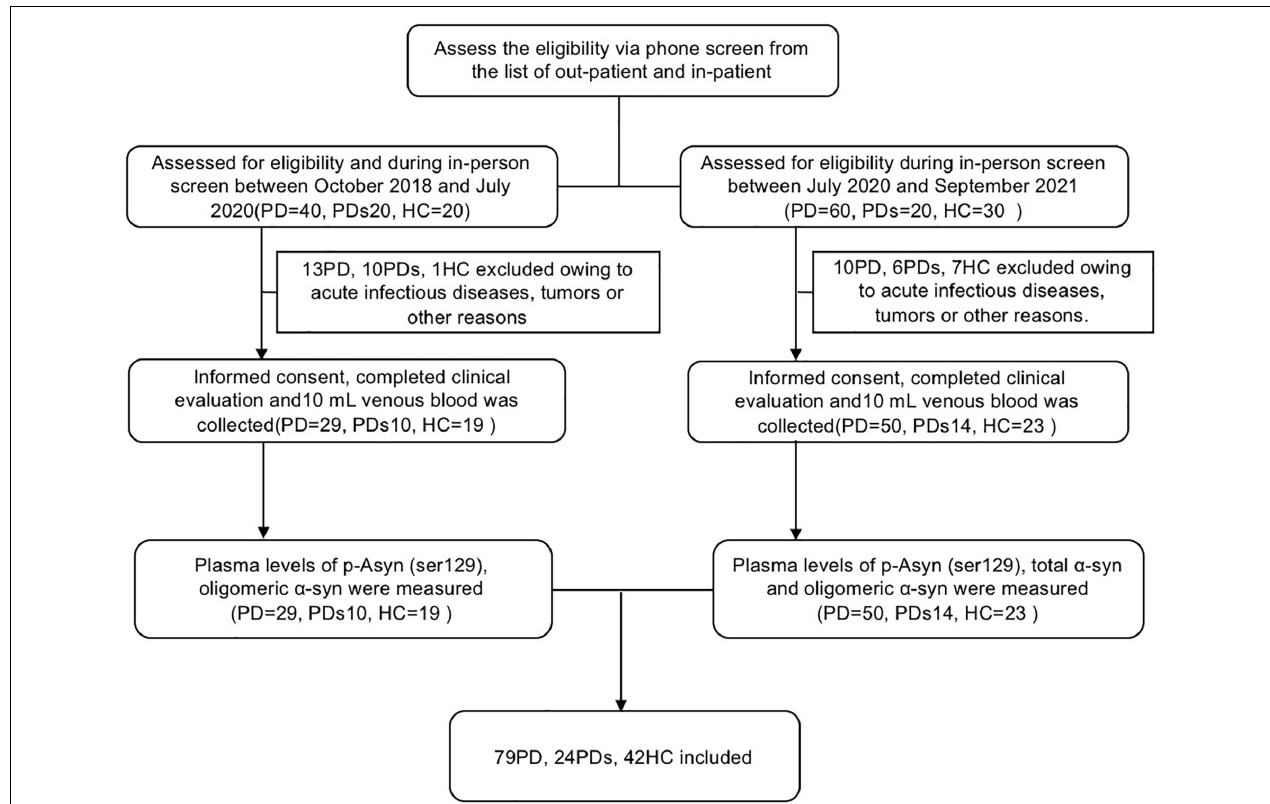
FIGURE 1 | The flow chart shows the whole process of this study. PD was diagnosed according to the MDS clinical diagnostic criteria. Healthy controls were spouses and friends of patients with PD and were neurologically normal participants, including movement disorders or dementia. All healthy controls were recruited from the same institute. PDs comprised MSA, PSP, or Vascular PD. In all subjects, those who had other neurodegenerative diseases, such as Alzheimer’s disease (AD), Wilson’s disease (WD), acute infectious diseases, and tumors, were excluded. Clinical PD and PDs diagnoses were performed by experienced movement disorders specialty-trained neurologists. Plasma levels of p-Asyn (ser129) and oligomeric α -syn were measured in the first group (screen between October 2018 and July 2020). To further assess the diagnostic value of a-synuclein, the measurement of total α -syn was added in the second group (screen between July 2020 and September